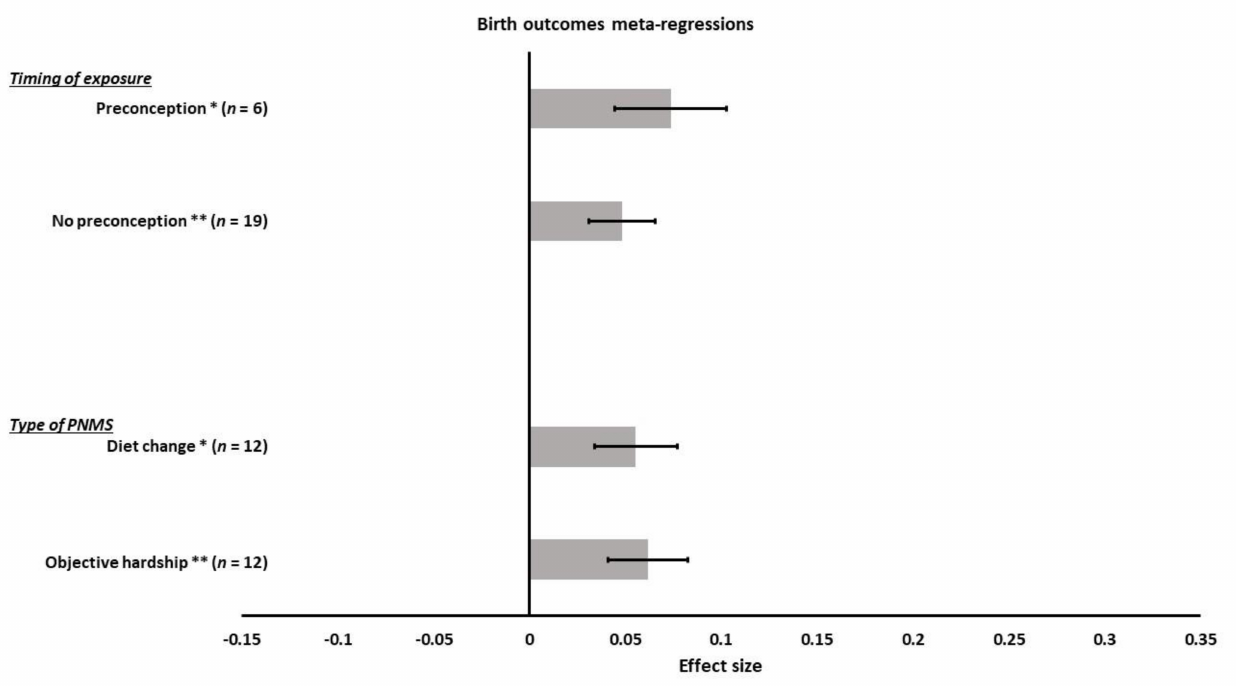
Figure 4. Birth outcomes meta-regressions. Type of PNMS effect (diet change; objective hardship) on birth outcomes and timing of exposure effect (no preconception; preconception) on the association between PNMS levels and birth outcomes. Note: * p < 0.05; ** p <